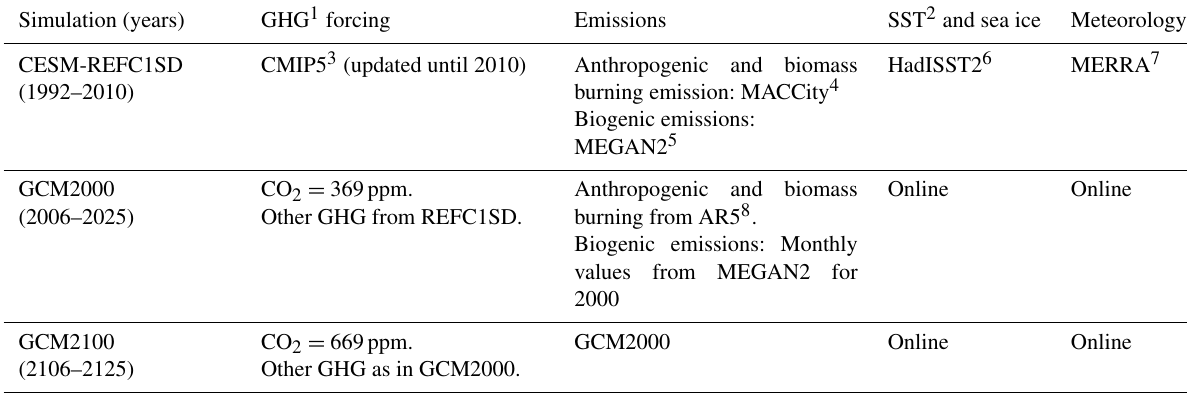
Table 1. Details and descriptions for each